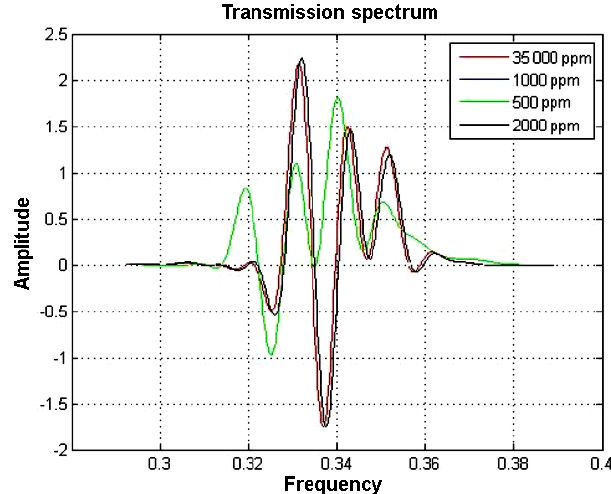
Figure 6. Transmitted spectrum for water with various salinity lev- els. The figure shows the overlapping of all the previous spectra to highlight the shift in the frequency and